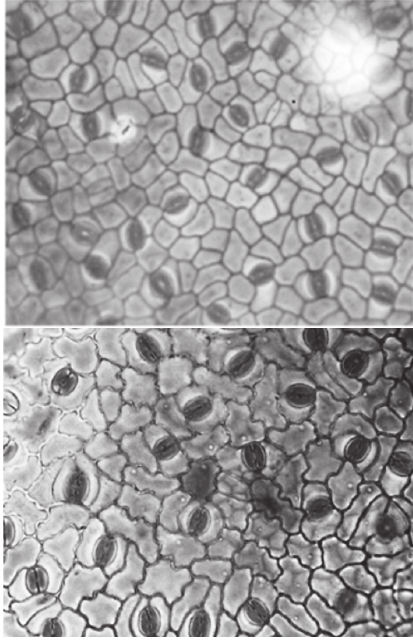
Figure 3 - Paradermic sections (lower epidermis) from the leaf of C. sylvestris var. sylvestris (a) and var. lingua (b)